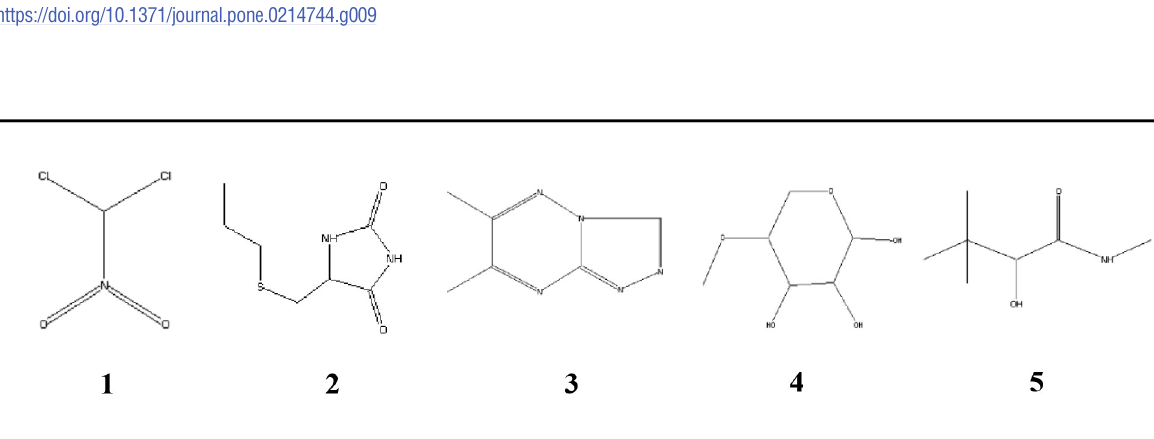
PLOS ONE | https://doi.org/10.1371/journal.pone.0214744 April 4,